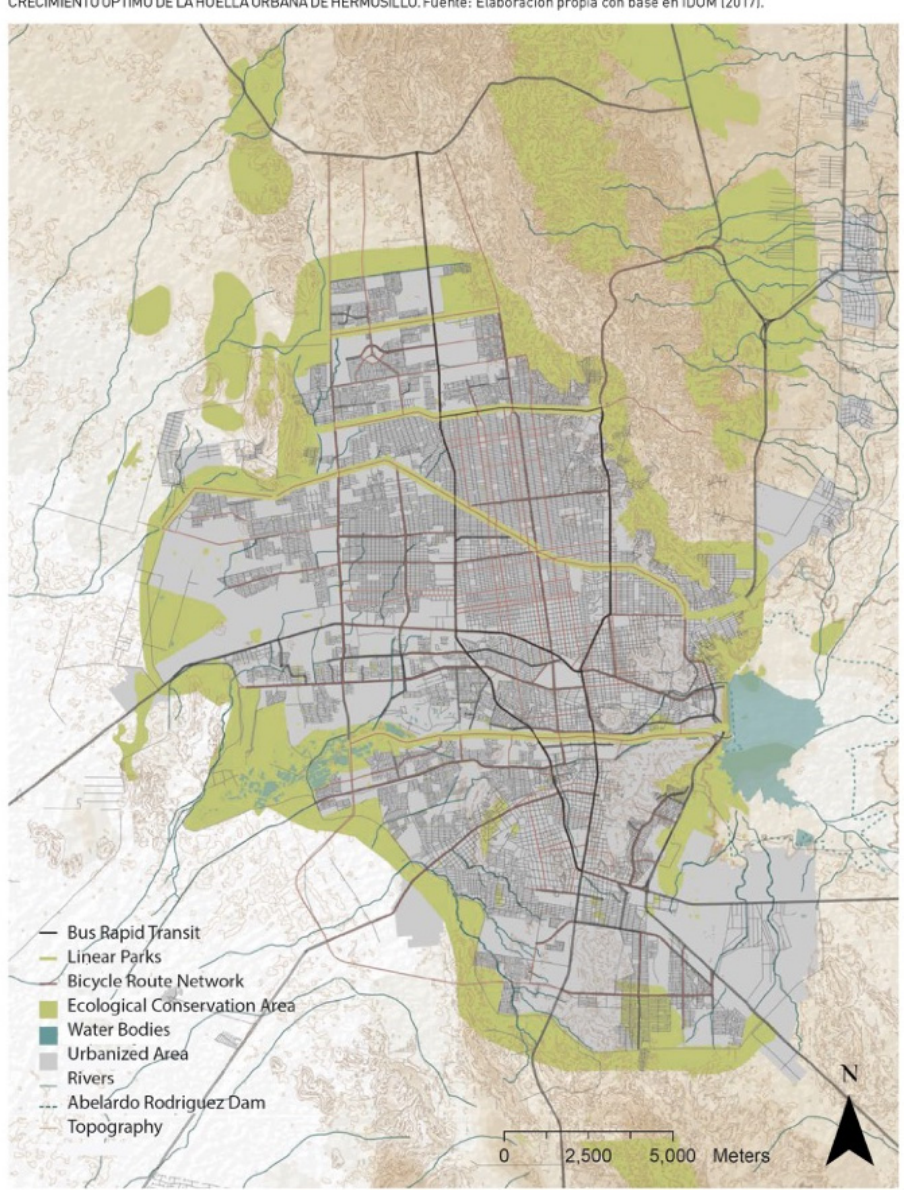
Figure 2. A green belt for Hermosillo. Green area shows envisioned ecological conservation areas surrounding the city (credit: C. Scarpitti based on IMPLAN map).